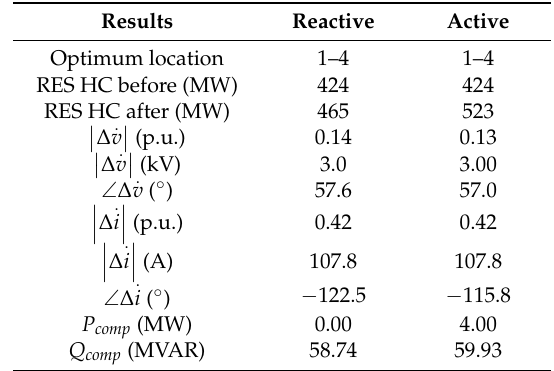
Table 10. Reactive combined FACTS results on the share of RES KPI. HC, Hosting Capacity.